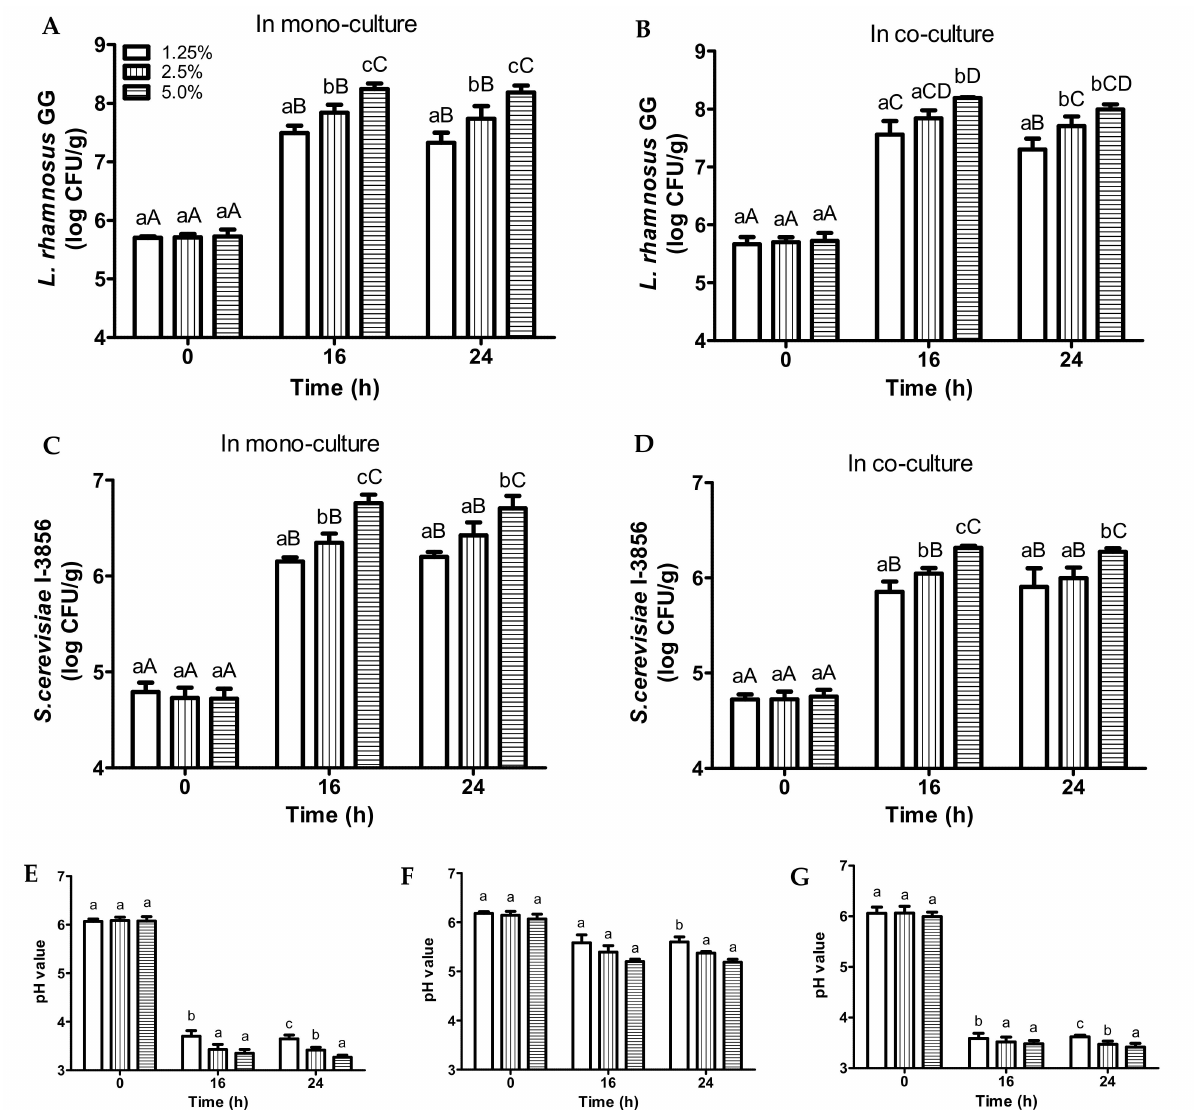
Figure 2. Changes in viable L. rhamnosus GG and S. cerevisiae CNCM I-3856 cell counts during 37 ◦ C incubation in bread slurries inoculated with L. rhamnosus GG only ( A ), L. rhamnosus GG + S. cerevisiae CNCM I-3856 ( B ), S. cerevisiae CNCM I-3856 only ( C ), and L. rhamnosus GG + S. cerevisiae CNCM I-3856 ( D ). Changes in pH during 37 ◦ C incubation for bread slurries inoculated with L. rhamnosus GG only ( E ), S. cerevisiae CNCM I-3856 only ( F ), and L. rhamnosus GG + S. cerevisiae CNCM I-3856 ( G ). Mean values at the same time point with different lower case letters are significantly different ( p < 0.05). Mean values at the different time points with different upper case letters are significantly different ( p <